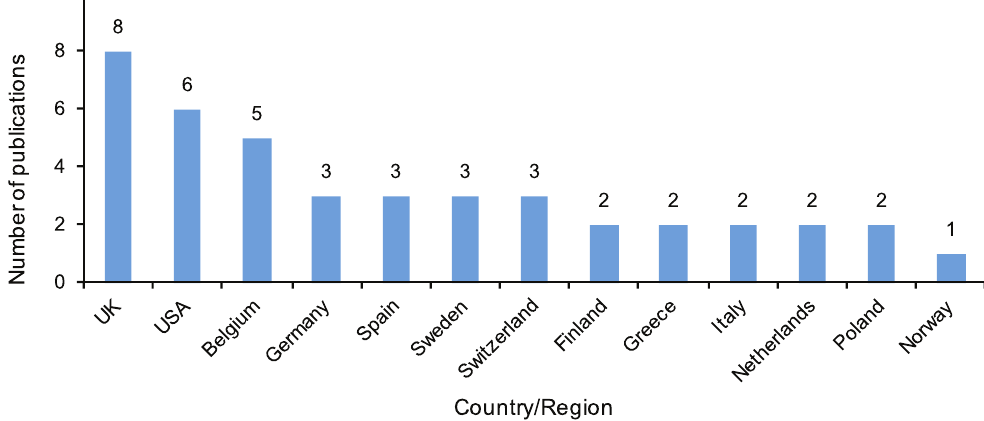
Figure 3: Information of countries which contributed to Research Frontier